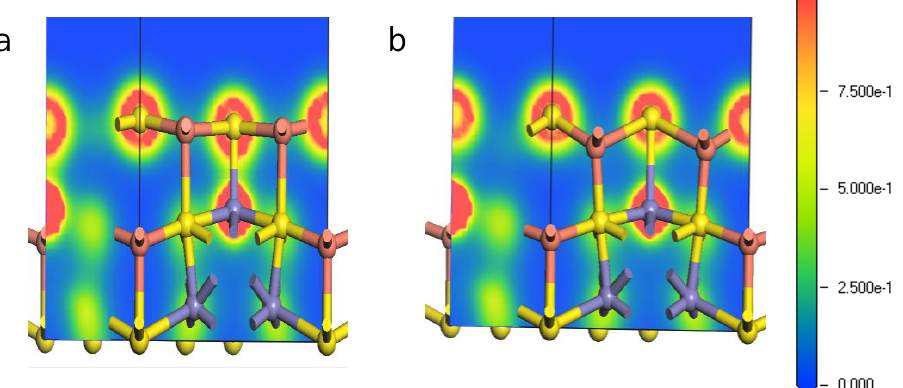
Figure 6. Electron density of Fe-S bond of bornite (111)-S surface before and after reconstruction in DFT calculation (CASTEP module of Materials Studio 6.0 software package, PBE density function, Hubbard + U correction): ( a ) The optimized Fe-S bond; ( b ) The initial Fe-S bond.